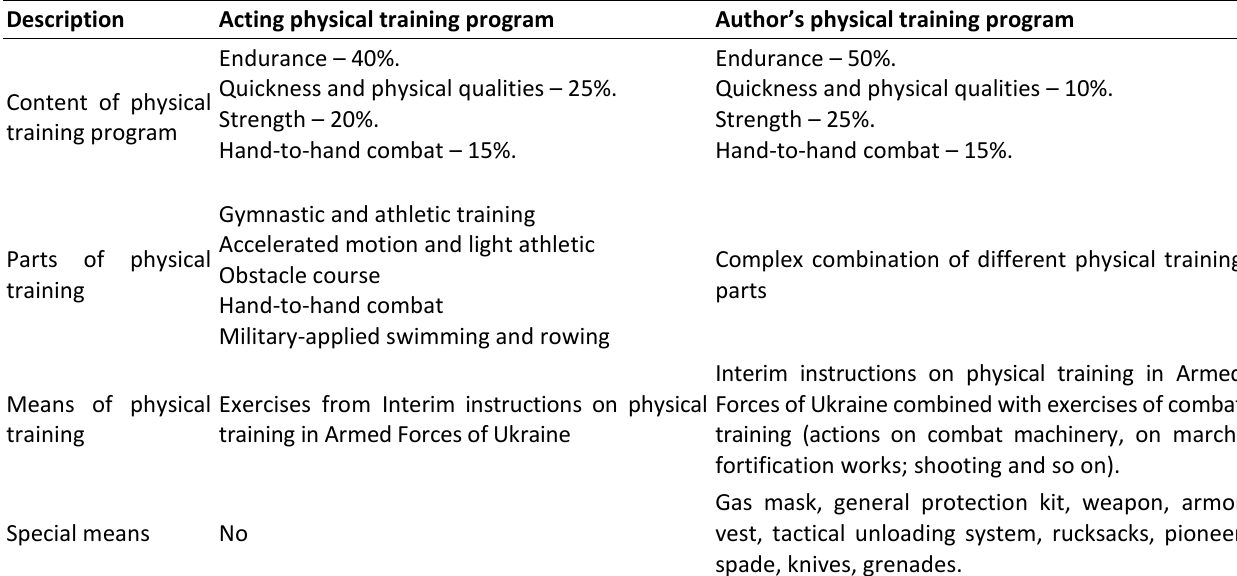
Table 1. Main distinctions of physical training programs for military college cadets